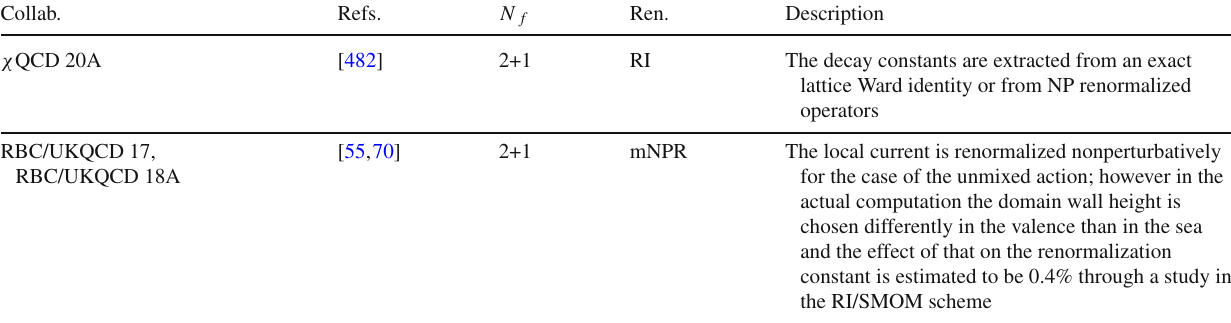
Table 131 Operator renormalization in N f = 2 + 1 determinations of the D - and D s -meson decay constants